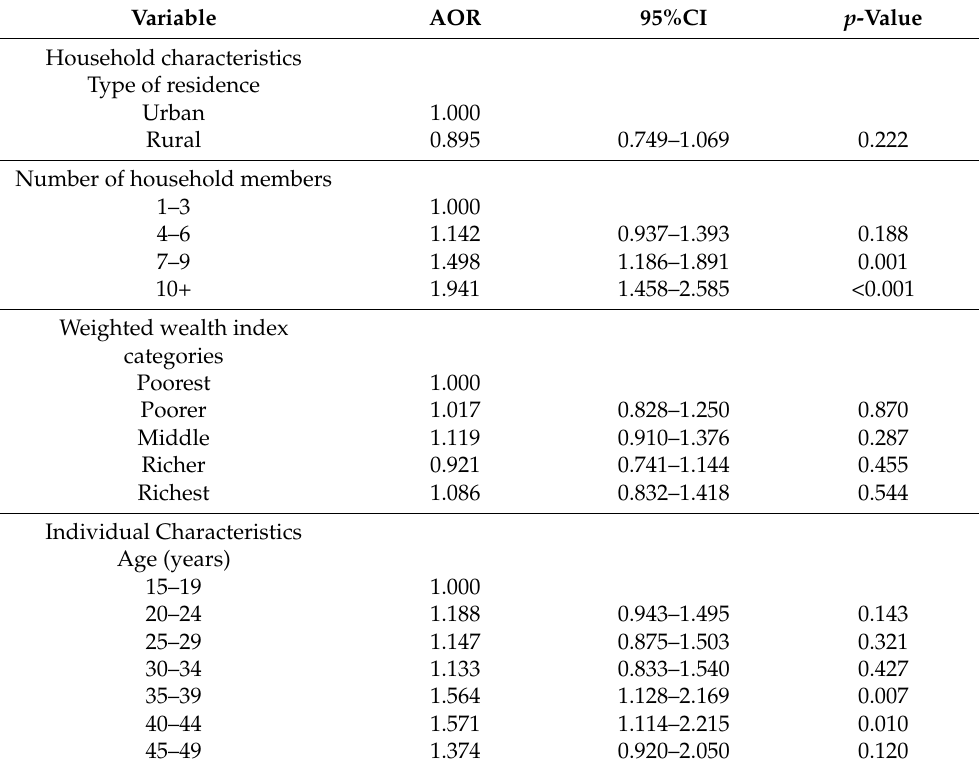
Table 4. Remaining factors associated with anemia among WRA using the recent TDHS 2015–2016. Variable AOR 95%CI p